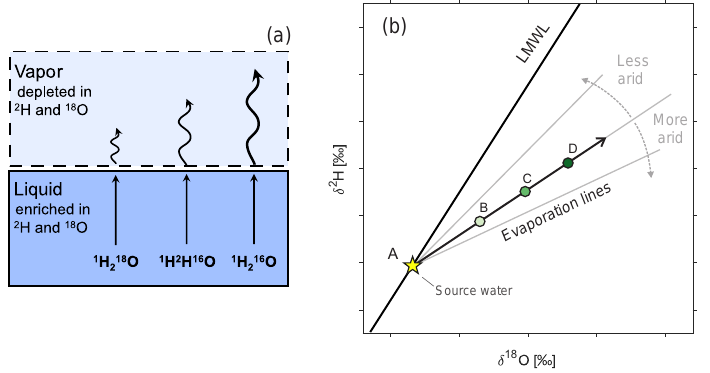
Figure 1. Fractionation effects during evaporation from an open water body. (a) Heavier water molecules ( 1 H 2 H 16 O, 1 H 18 O) break their 2 bonds and evaporate less readily than lighter water molecules ( 1 H 16 O), and thus have lower saturation vapor pressures. Heavier molecules 2 also diffuse away from the evaporating surface less rapidly. As a consequence, during evaporation, lighter water molecules vaporize faster than heavier water molecules. The ratios between the evaporation rates of the different water isotopologues (net of any condensation) deter- mine the slope of the evaporation line describing the progressive isotopic enrichment of the liquid water that is left behind. (b) Progressive enrichment (dots B–D) of a water source (yellow star A). The evaporation line typically lies below the local meteoric water line (LMWL), at an angle that depends on the aridity and the isotopic composition of the atmosphere (and thus on the relative rates of re-condensation of each isotopologue). (a) was adapted from Leibundgut et al.